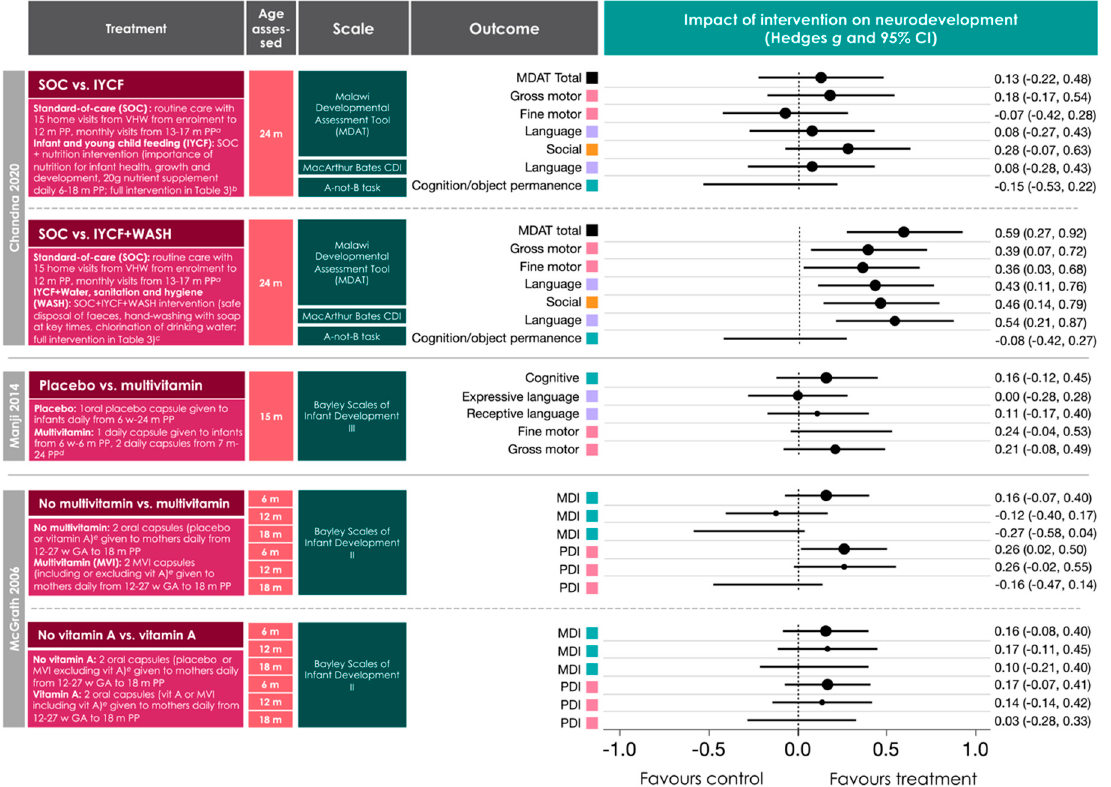
Figure 5. Summary of the results from randomised controls trials investigating the influence of early-life nutrition related interventions on neurodevelopmental outcomes in the first 24 m of life in infants exposed to HIV. Full descriptions of the study treatments or interventions are presented elsewhere (Supplementary Table S3). Chanda et al. (2020) [52] report positive e ff ects of a combined IYCF + WASH intervention on motor, language, and behavioural outcomes at 24 months in a group of 300 infants who are HEU. McGrath (2006) [51] reports positive e ff ects of daily maternal multivitamin supplementation from 12–27 weeks’ gestation to 18 months postpartum on motor developmental outcomes in 327 infants exposed to maternal HIV infant (breakdown of infant HIV status not provided) at six months of age. Methodological quality assessments for these studies are reported in Figure 3. Data are presented in forest plots as Hedge’s g (95% CI) in ascending order according to infant age at assessment. SOC = standard-of-care; ICYF = Infant and young child feeding; WASH = water, sanitation, and hygiene; VHW = village health worker; MDAT = Malawi Developmental Assessment Tool; CDI = Communicative Development Inventories; d = days; w = weeks; m = months; PDI = psychomotor development index; MDI = mental development index; CI = confidence interval; HEU = HIV-exposed, uninfected.